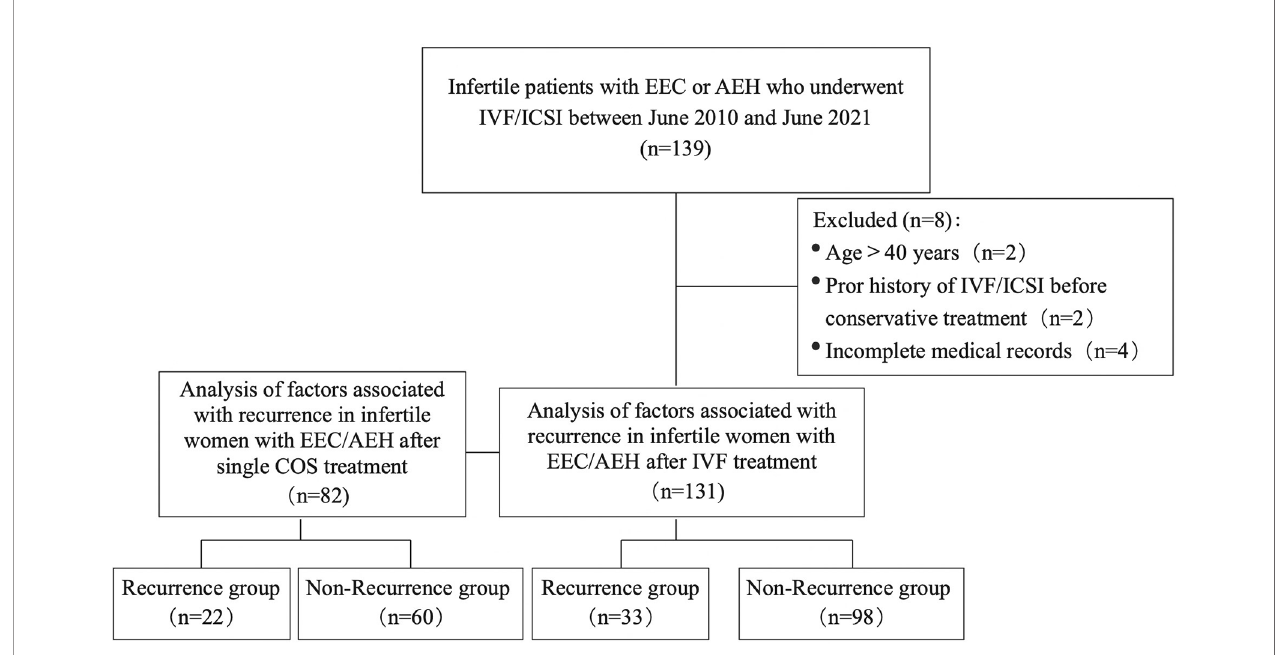
FIGURE 1 | Flow chart of the analysis